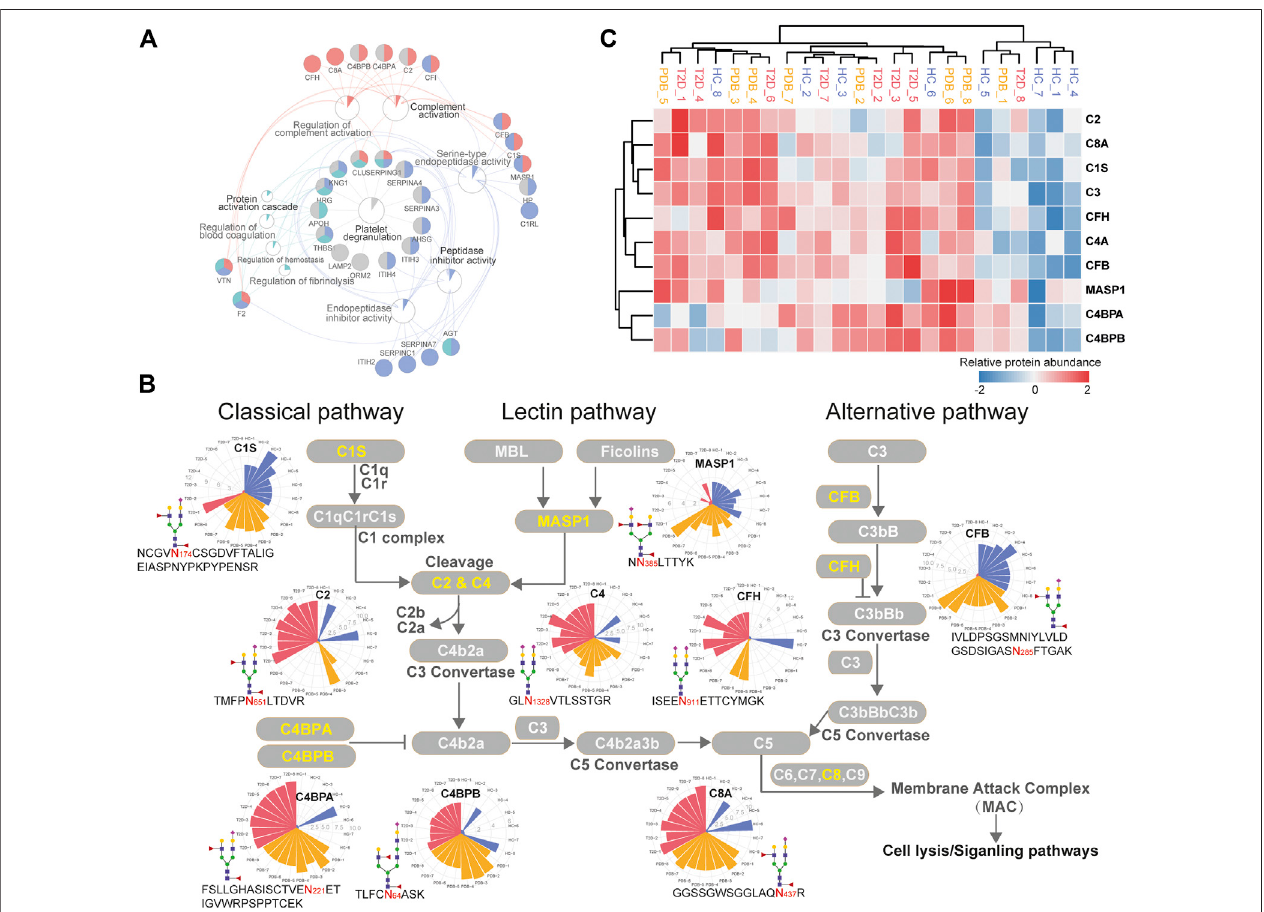
FIGURE 6 | Dysregulation of N-linked glycosylation of complement activation pathways in T2D. (A) Pathway and protein interaction network of the mapped proteins from T2D signature N-glycopeptides. Distinct functional modules are annotated with different colors. The node size is determined by the number of proteins identi fi ed in that pathway, and the size of colored pie chart re fl ects the proportion of identi fi ed proteins of that pathway. (B) Network diagram summarizes relevant signature N-glycopeptides and signaling cascades involved in complement activation pathways. The proteins with N-glycosylation alterations are annotated as yellow characters, and their altered glycopeptides, glycosites, glycan compositions, and N-glycopeptide abundance are displayed. The relative abundance of N-glycopeptides is depicted as radar circles. Blue, HC individuals; yellow, PDB subjects; red, T2D patients. (C) Heatmap depicting the corresponding expression levels of the proteins discussed in complement activation